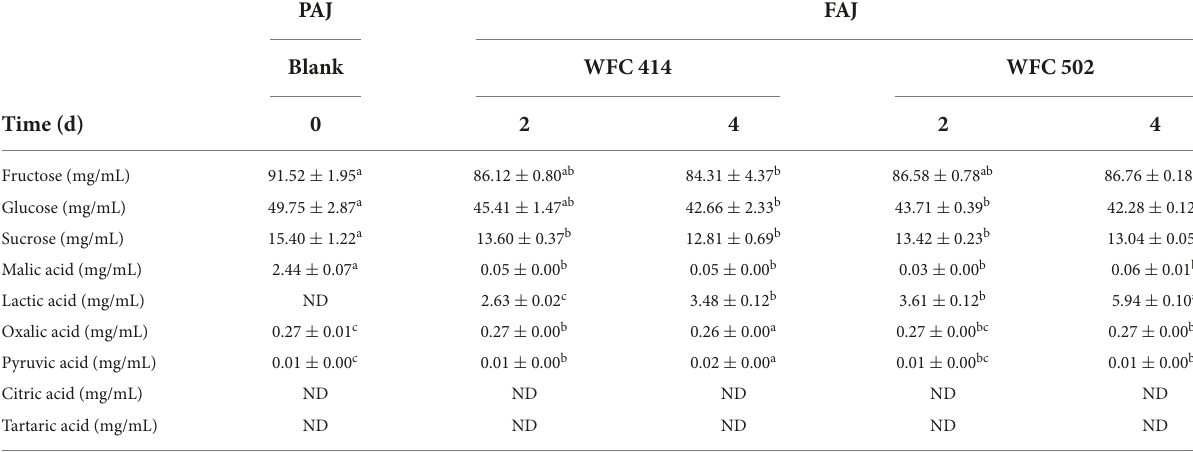
TABLE 3 Soluble sugars (fructose, glucose, and sucrose) and organic acids (malic acid, lactic acid, oxalic acid, pyruvic acid, citric acid, and tartaric acid) of apple juice before and after fermentation by WFC 414 and WFC